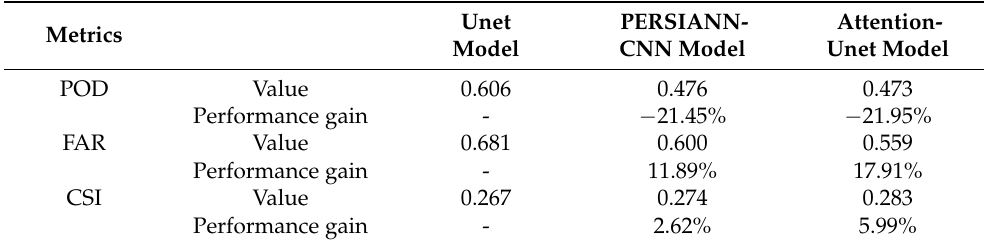
Table 8. Summary of precipitation identification performances over the verification periods.